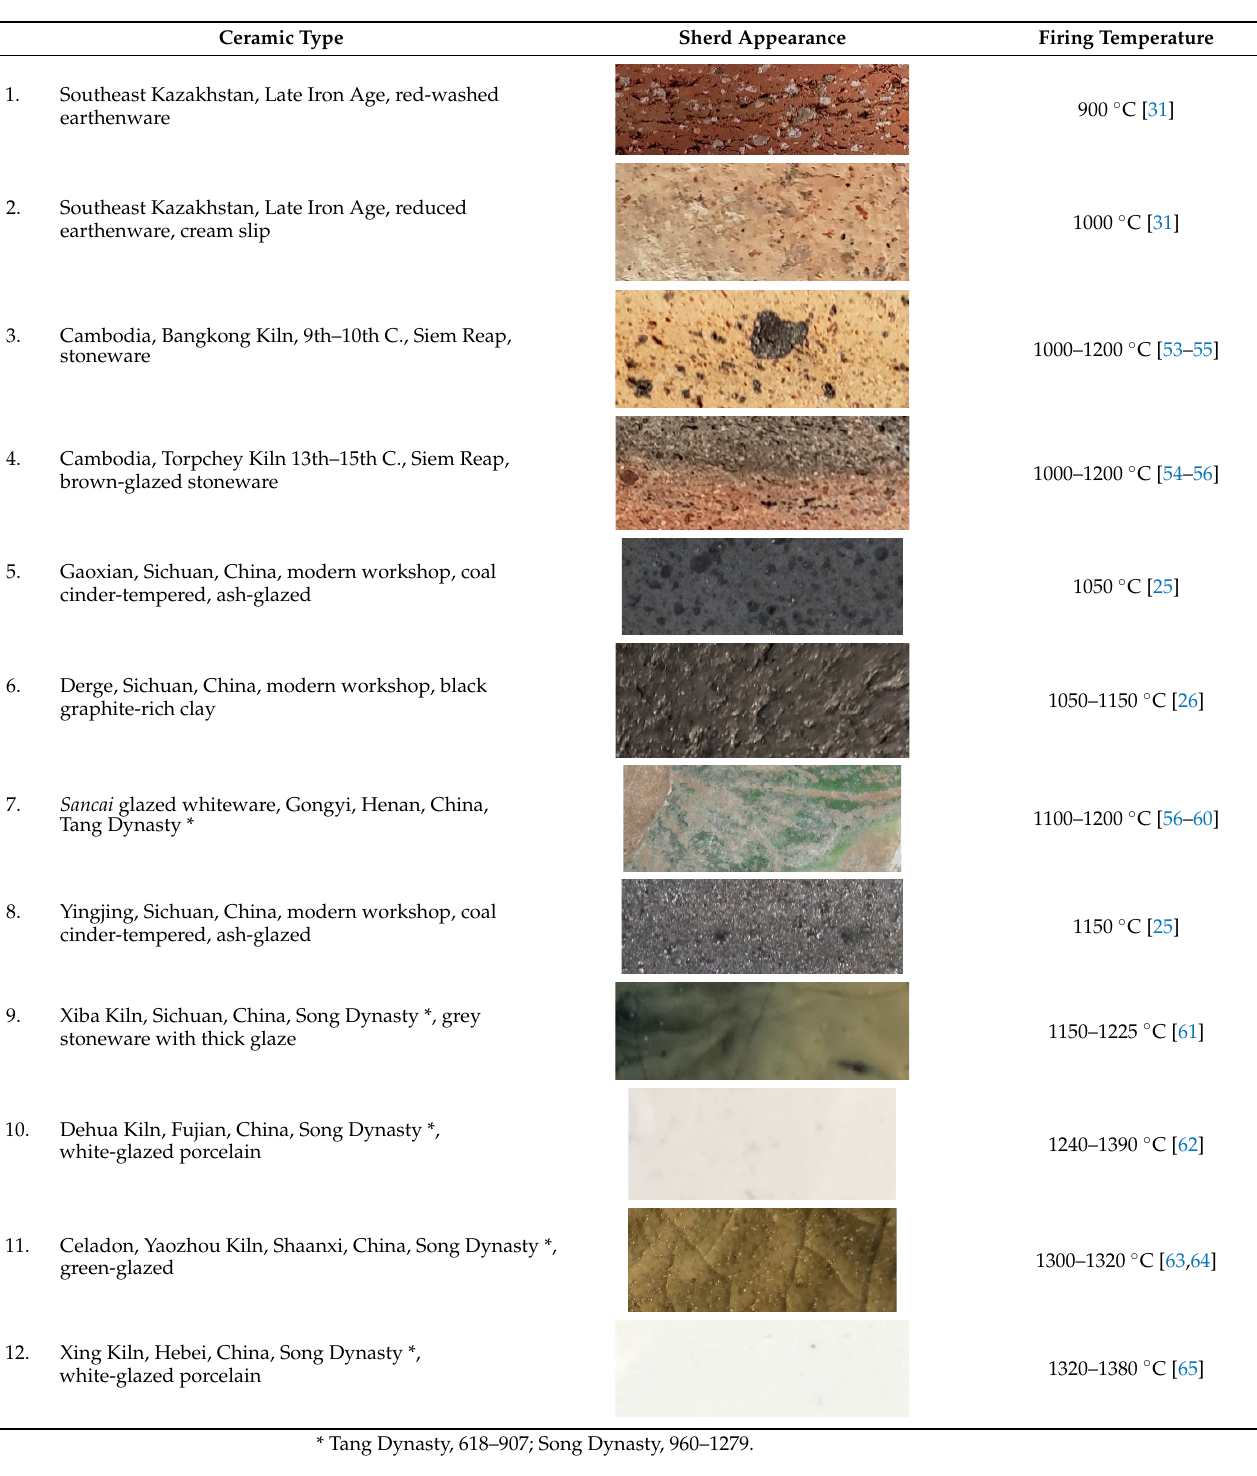
Table 1. Ceramic sherds studied with firing temperature ranges.